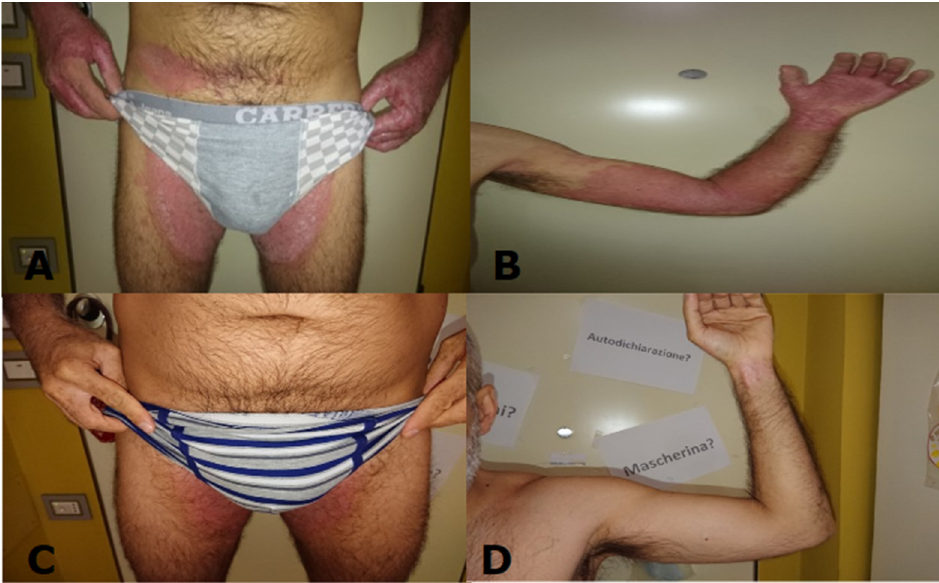
Figure 1. ( A ) Patient at baseline genital area; ( B ) patient at baseline left arm; ( C ) patient after one year, genital area; ( D ) patient after one year, left arm.